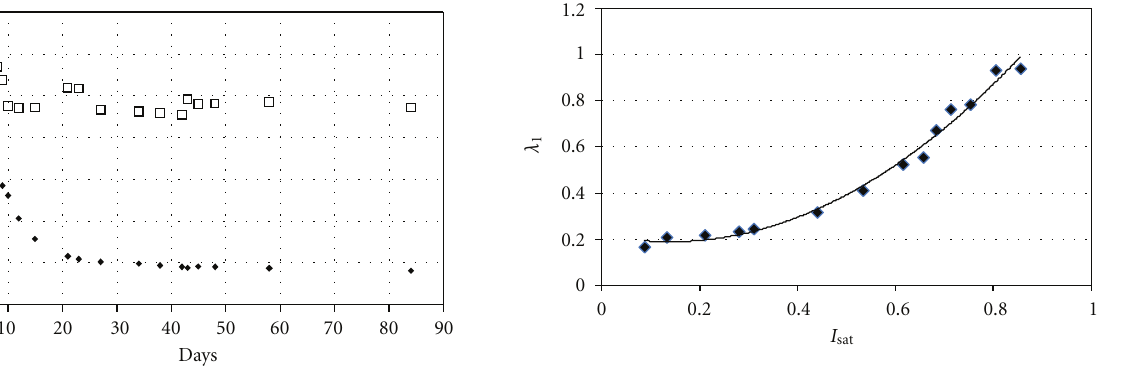
Figure 10: Evolution of λ 1 (black lozenges) and λ 2 (white squares) thermal conductivities with time. The λ 1 and λ 2 are calculated from the curve slope measured in the [ − 2 − 1]ln( t ) and [+1 + 2]ln( t ) intervals (Figure 9). According to the drastic a 1 increase the λ 1 values decrease from 0.9 to 0.2W/mK during the 20 first days. The λ 2 shows dispersive values around 0.97 W/mK.